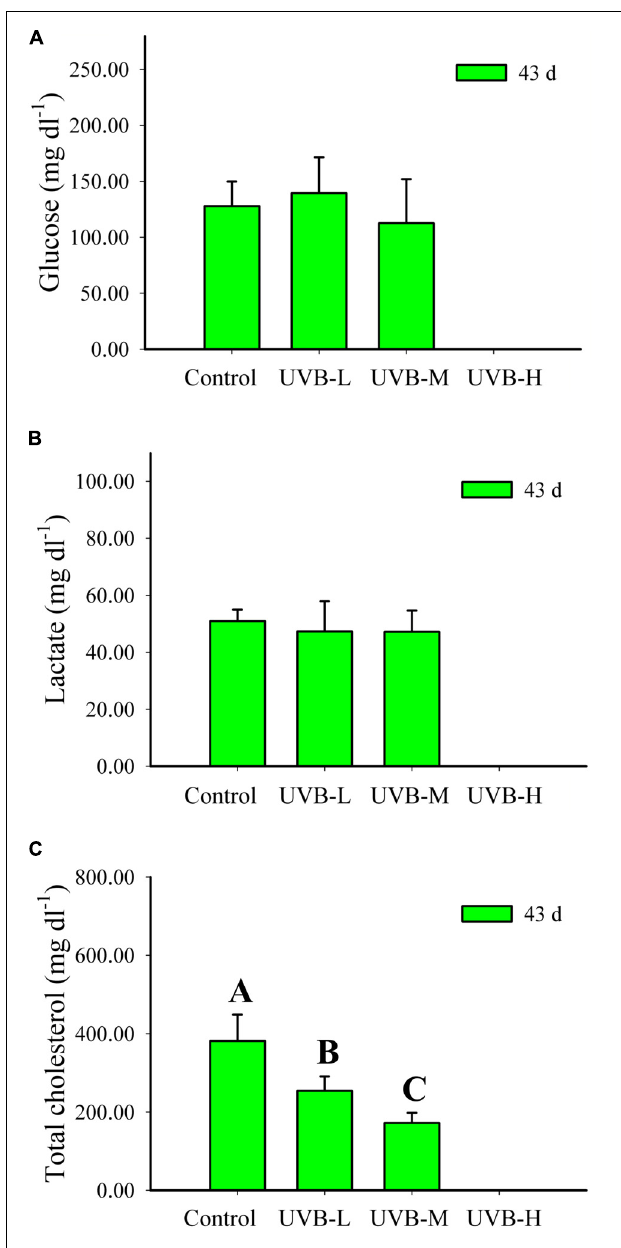
FIGURE 5 | (A) Glucose (mg dl − 1 ), (B) lactate (mg dl − 1 ), and (C) total cholesterol (mg dl − 1 ) in plasma of S. aurata after 43 days of exposure to UVB (glucose: mean ± SD, n = 16; lactate and total cholesterol: mean ± SD, n = 10). Significant differences between treatments are represented by different capital letters ( P < 0.05; one-way